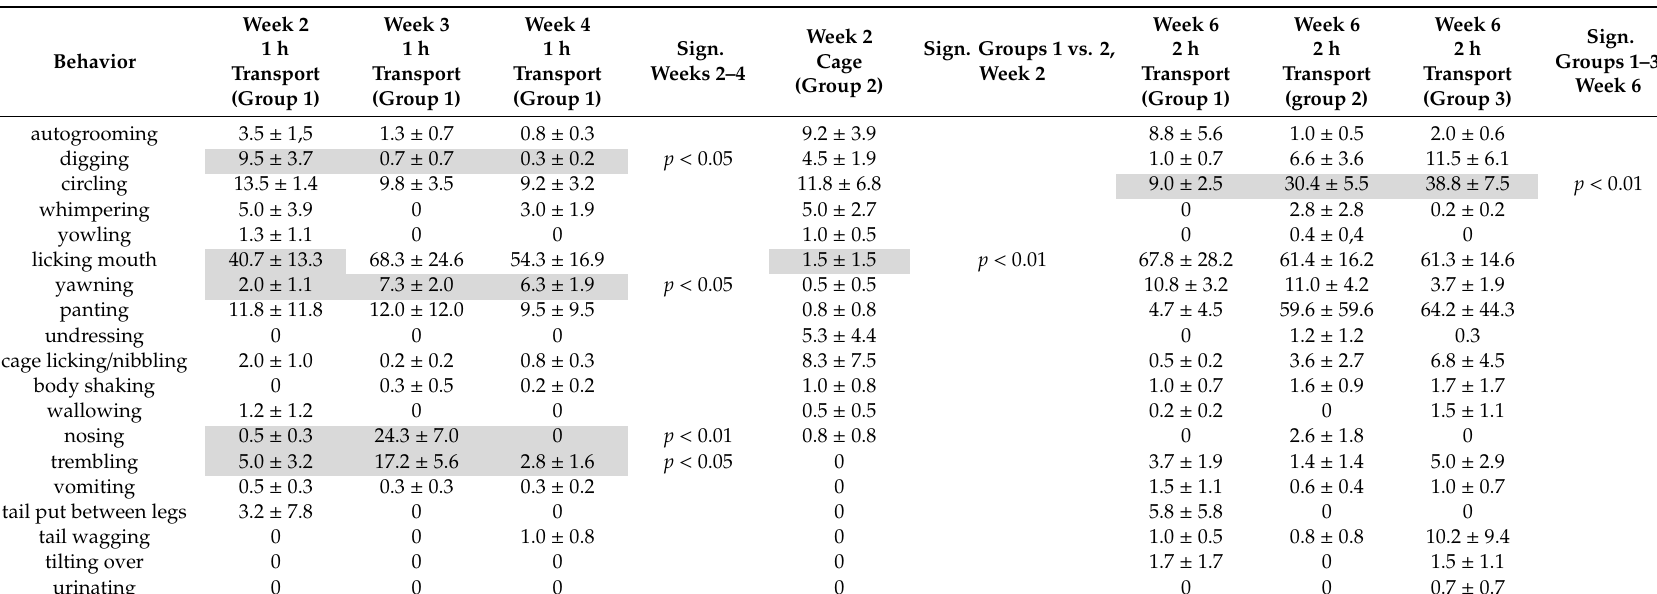
Table 5. Occurrence of behavior patterns during one hour road transport or in control dogs in the stationary car (data indicate number out of 240 intervals of 15 s each in which the behavior was shown) and during two hour road transports (data indicate number out of 480 intervals of 15 s each, in which the behavior was shown), n = 6 per group, data are mean ±